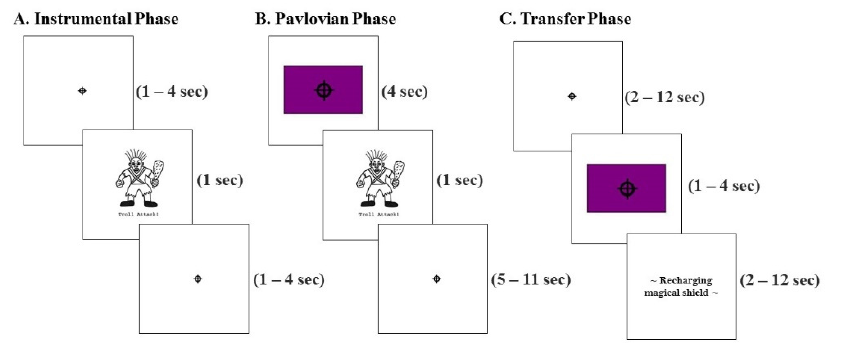
Figure 1. Schematic of the PIT task. ( A ) Instrumental phase: An aversive outcome (1 sec) occurred after each fixation cross. Participants were free to utilize R1 and R2. The correct response prolonged the onset of the next aversive event by 3 s. Participants completed two blocks of instrumental conditioning for each aversive outcome (O1 and O2). ( B ) Pavlovian Phase: participants viewed five randomly ordered CS-O contingencies and were told to remember the contingencies presented. ( C ) Transfer phase: Participants were shown CS1CS5 in random order after a fixation cross and before a “recharging” period. Participants were instructed to not respond during the recharge period but were free to respond at any other point during this